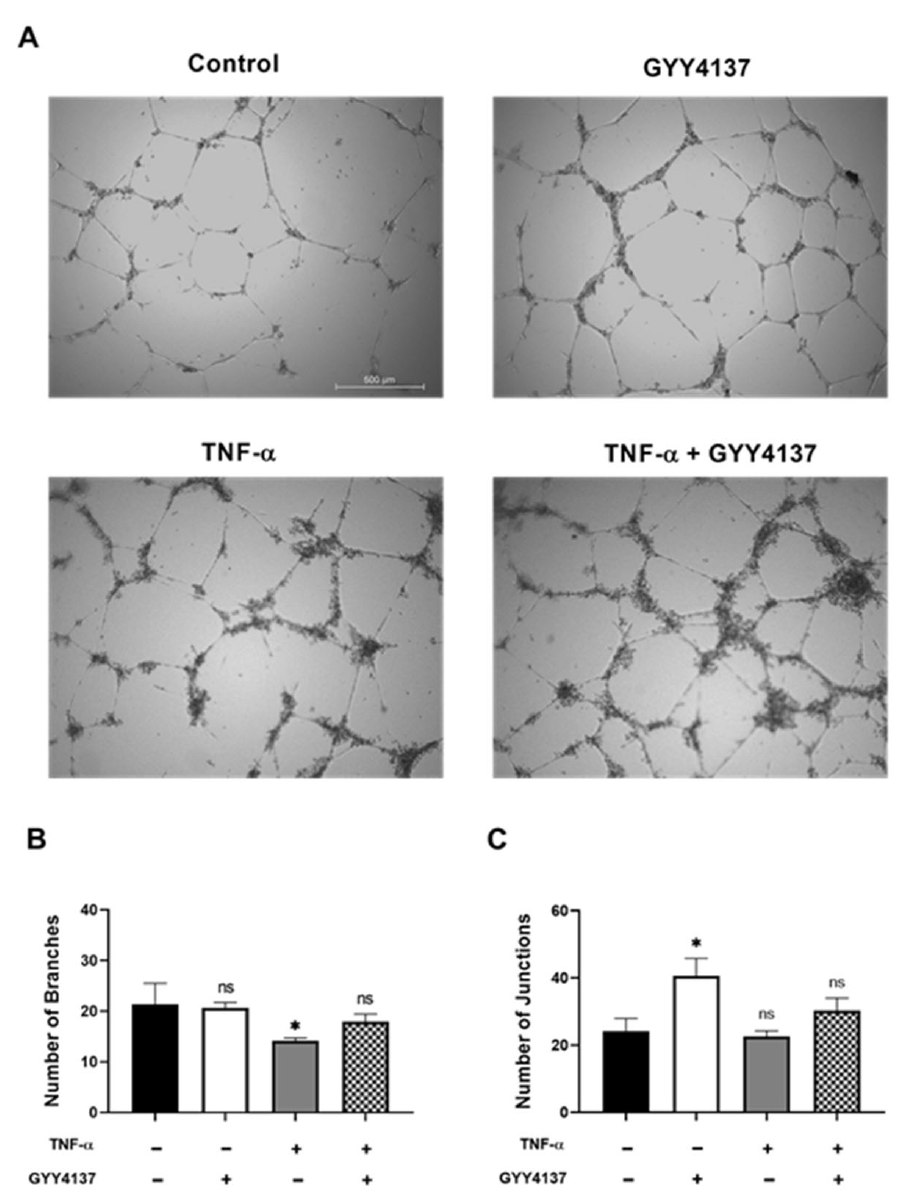
Figure 2. Effects of GYY4137 in endothelial angiogenesis. HUVECs were treated with TNF- α (1 ng/mL, 3 h) followed by GYY4137 (100 µ M, 21 h). ( A ) Representative images of vessel formation by HUVECs. A Nikon microscope captured images using 4 × objective magnification (scale bar: 500 µ m). ( B ) The number of branches and ( C ) the number of junctions was analysed by ImageJ software. Results were shown as mean ± SD, 3 independent experiments with 3 replicate in each experiment. Significance was determined by a one-way ANOVA test followed by Tukey’s post-test comparing treatments to control. ns. (non-significant), * p < 0.05 compared to